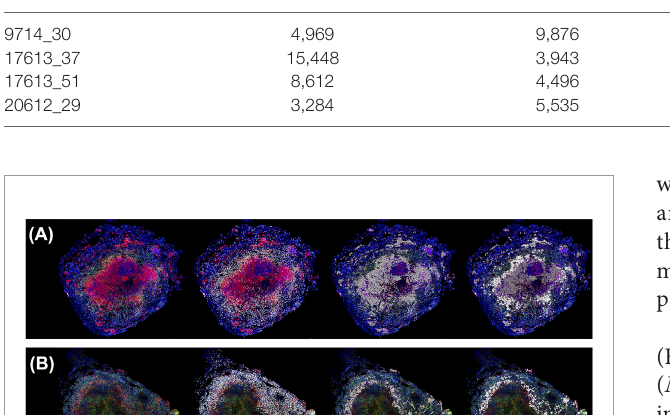
TABLE 2 | Geographical Information Systems Technology (GIS) analysis identi fi es numbers of cells of two types, and numbers of contacts from four immunohistochemistry (IHC) granulomas. Granuloma CD3